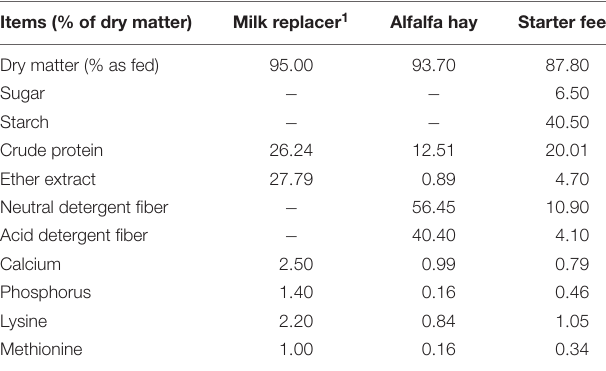
TABLE 1 | Nutrient composition of the milk replacer, alfalfa hay, starter used in the present study. Items (% of dry